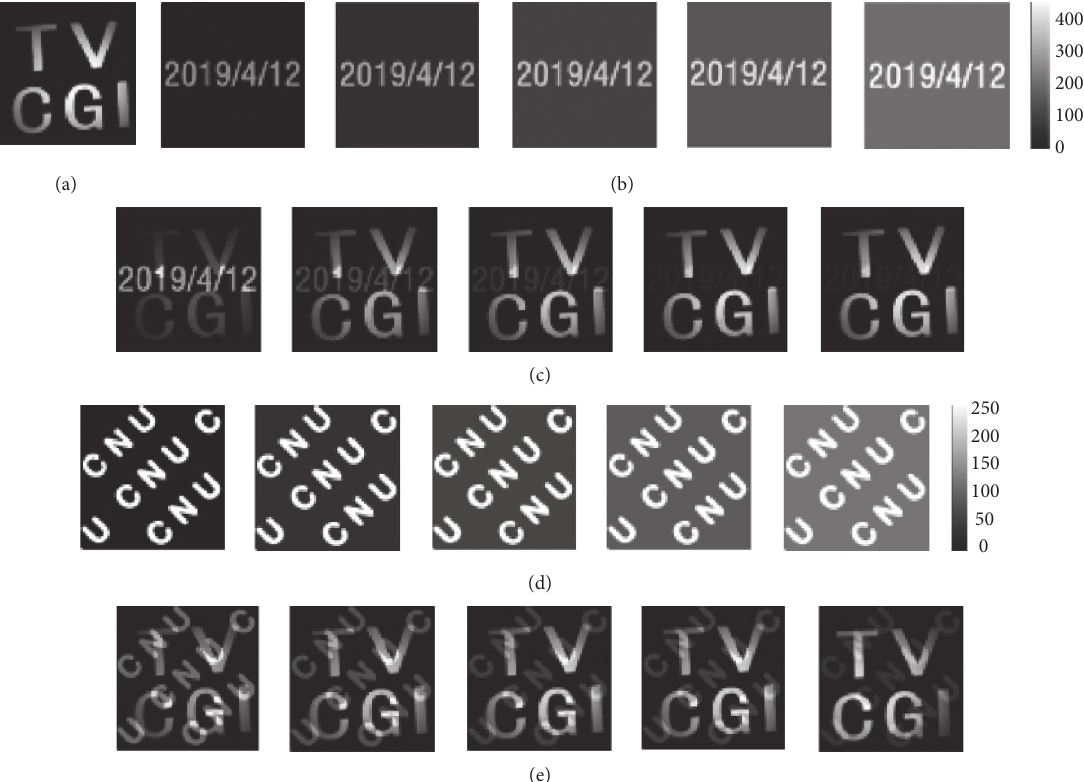
Figure 5: Experimental results of optical watermarking. (a) Original image obtained by CGI using the Hadamard matrix. ((b) and (d)) A set of watermark patterns. ((c) and (e)) Their corresponding imaging results.